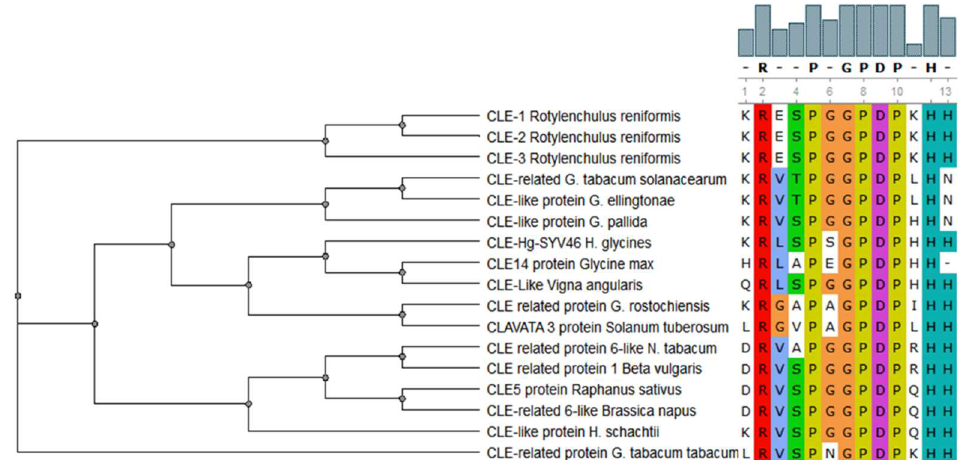
Figure 2. Conservation of the CLE motif (xRxxPxGPDPxHx) in CLAVATA/ESR (CLE) peptides in different plant parasitic nematodes (PPNs) and plant species [4]. This multiple alignment demonstrates the highly conserved amino acid residues of CLE motif between PPNs and their corresponding host plants.